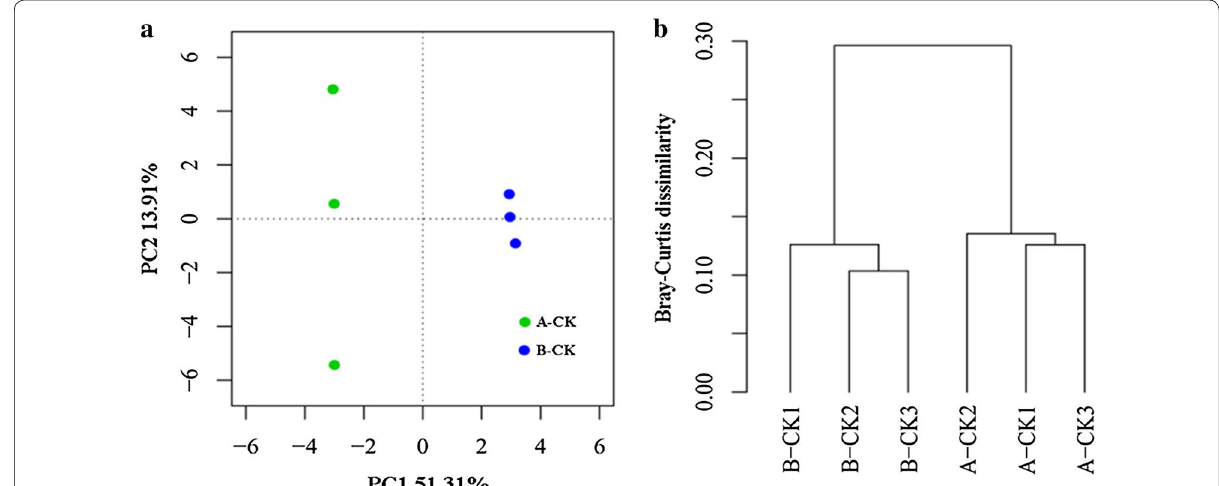
Fig. 3 a Principal component analyses (PCA) and b cluster analysis of each sample by Ward method. B-CK treatment of inoculated SQR-21 without bacteria side, A-CK no bacteria inoculated as